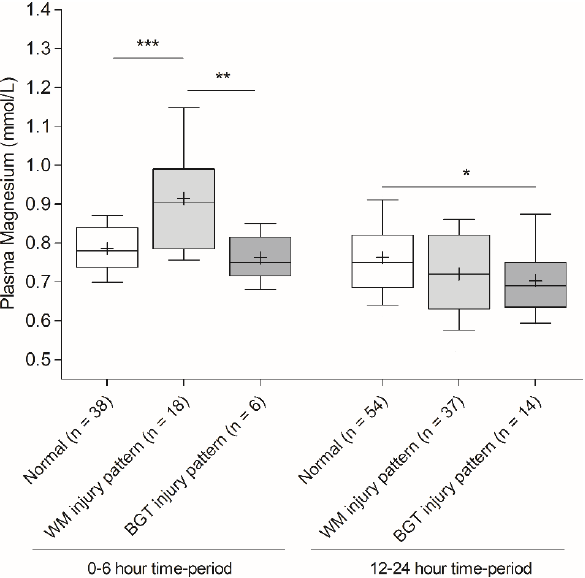
Figure 3. Plasma magnesium values measured before the sixth hour of life and during the 12–24 h time-period according to the brain injury pattern. White box-and-whiskers plots represent infants with normal MRI. Light grey box-and-whiskers plots represent infants with white matter injury pattern. Dark grey box-and-whiskers plots represent infants with basal ganglia-thalamus injury pattern. Crosses in box-and-whiskers plots correspond to the means. Statistical analysis: one-way ANOVA with Bonferroni’s post-test, * p < 0.05, ** p < 0.01 and *** p < 0.001. WM: White matter, BGT: Basal